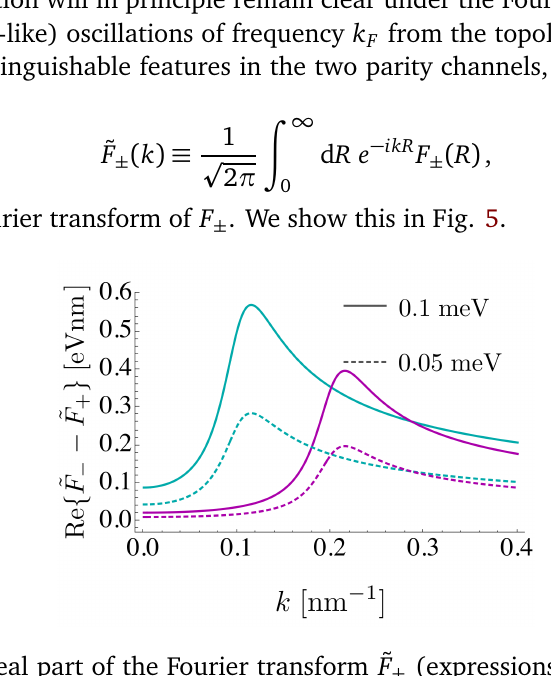
Figure 5: The real part of the Fourier transform ˜ F ± (expressions listed in Appendix C) of the parity disparity F − − F + at zero temperature as a function of